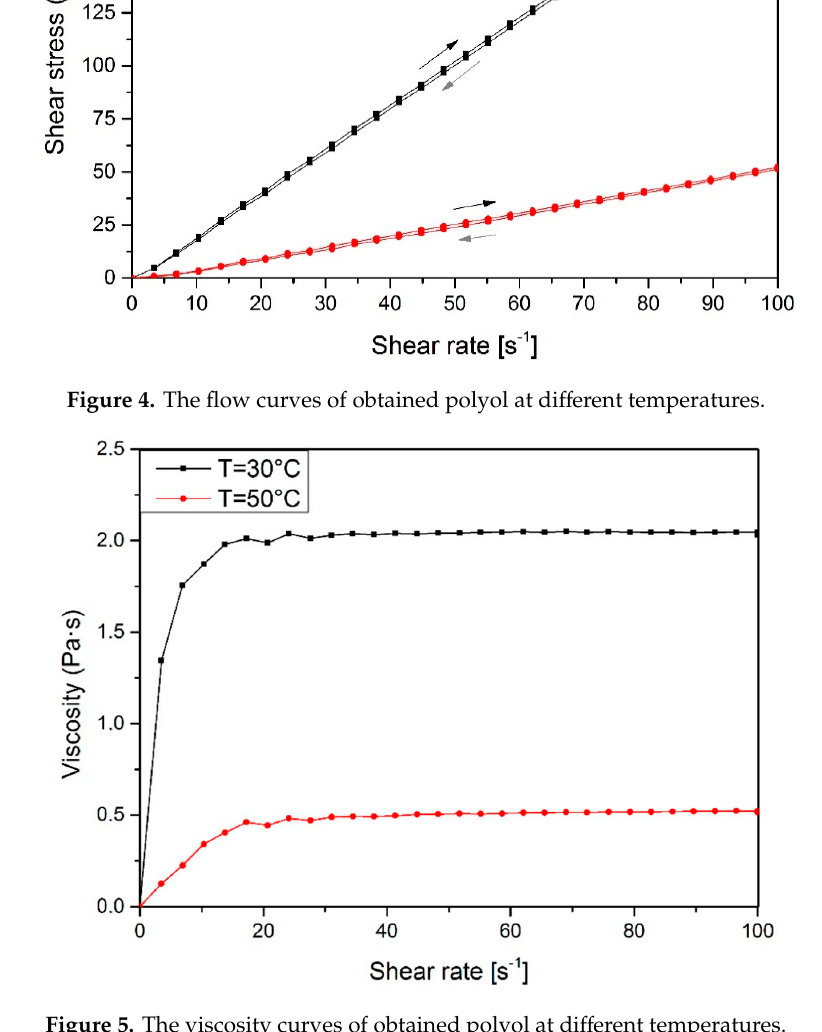
Figure 5. The viscosity curves of obtained polyol at different temperatures.